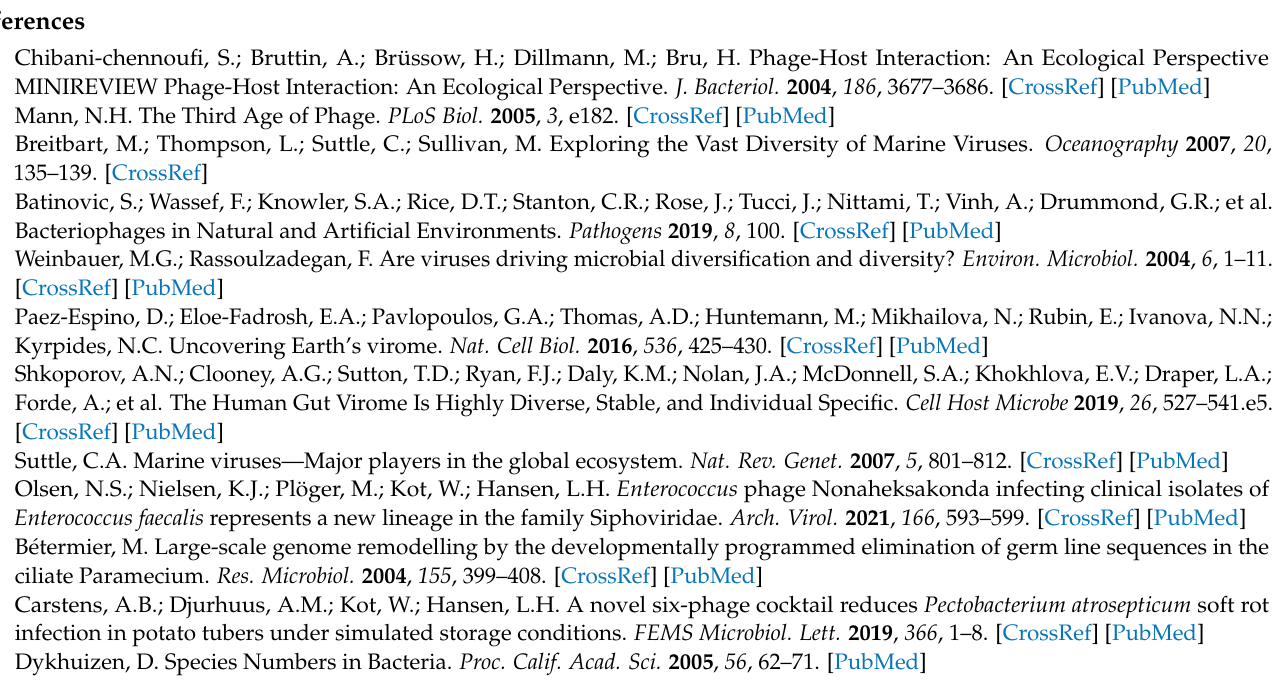
OTU composition; Figure S7. Accumulative abundance of all contigs in the three sample types; Ta- ble S8. Observed vOTUs in each of the virome samples; Table S9. Read mapping coverage of plaque- forming phages from organic waste sample; Table S10. CRISPR hits on host taxonomy at species level; Table S11. Putative phage contigs that had a Log2FC above 1 or below − 1; Table S12. Putative phage contigs that had a Log2FC between − 1 and 1 without a significant